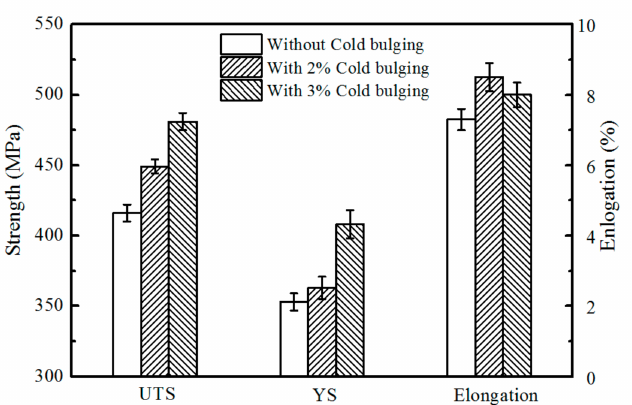
Figure 14. Mechanical properties of the samples under different cold bulging conditions.